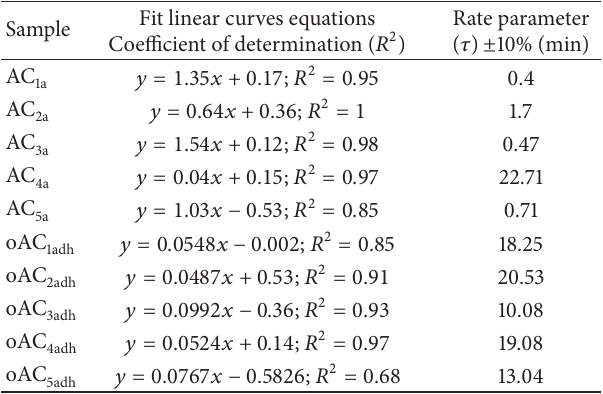
–oAC ) cross-linked hydrogel 1adh 5adh